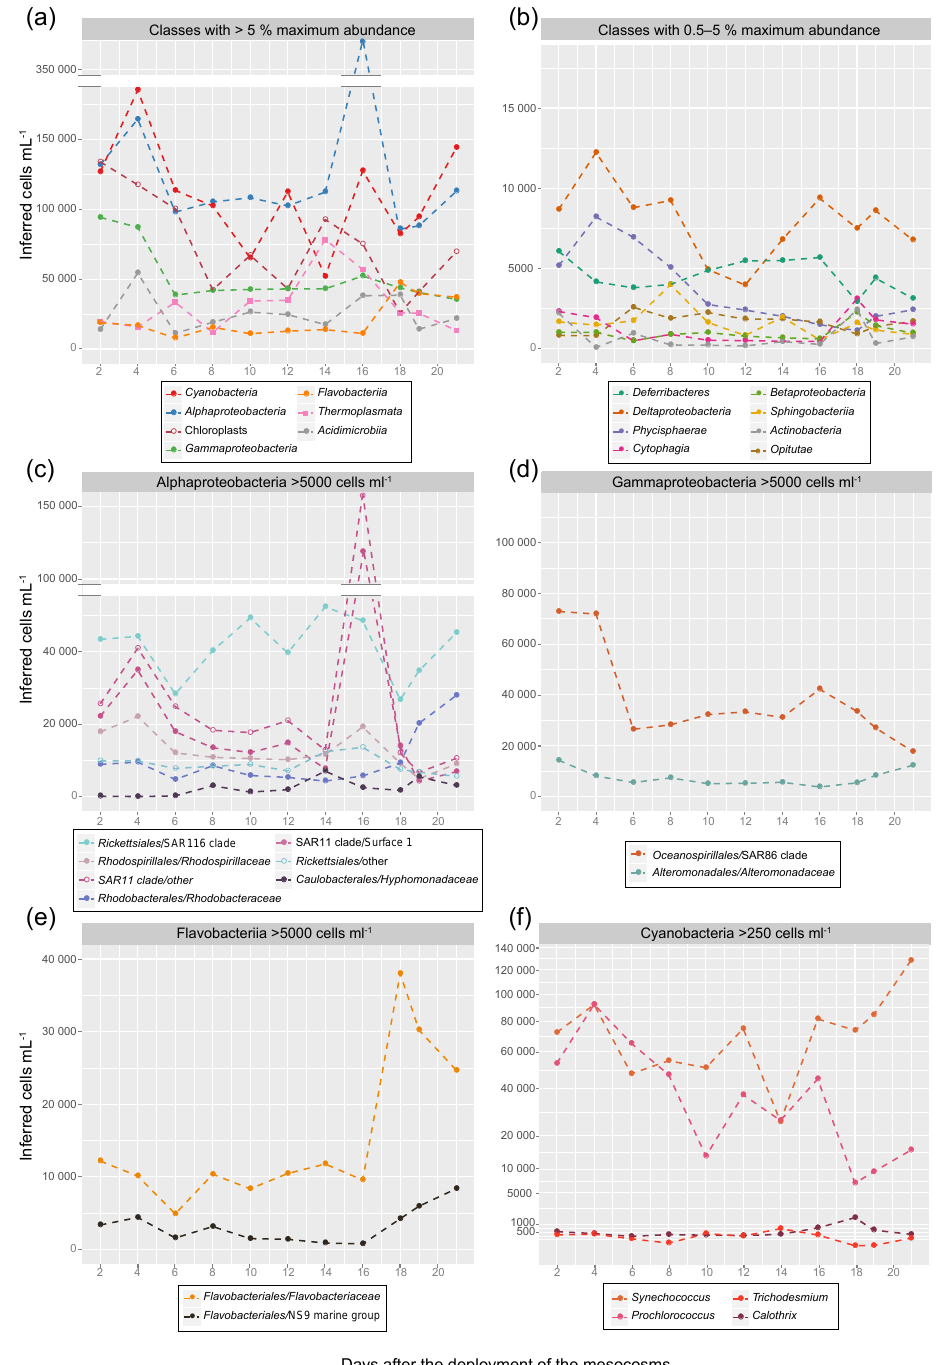
Figure 4. Evolution of the 16S community with time for surface samples in the Nouméa lagoon waters. All abundances are given as inferred absolute abundances in cellsmL − 1 as described for Fig. 3. Data were plotted in the same way as for Fig.